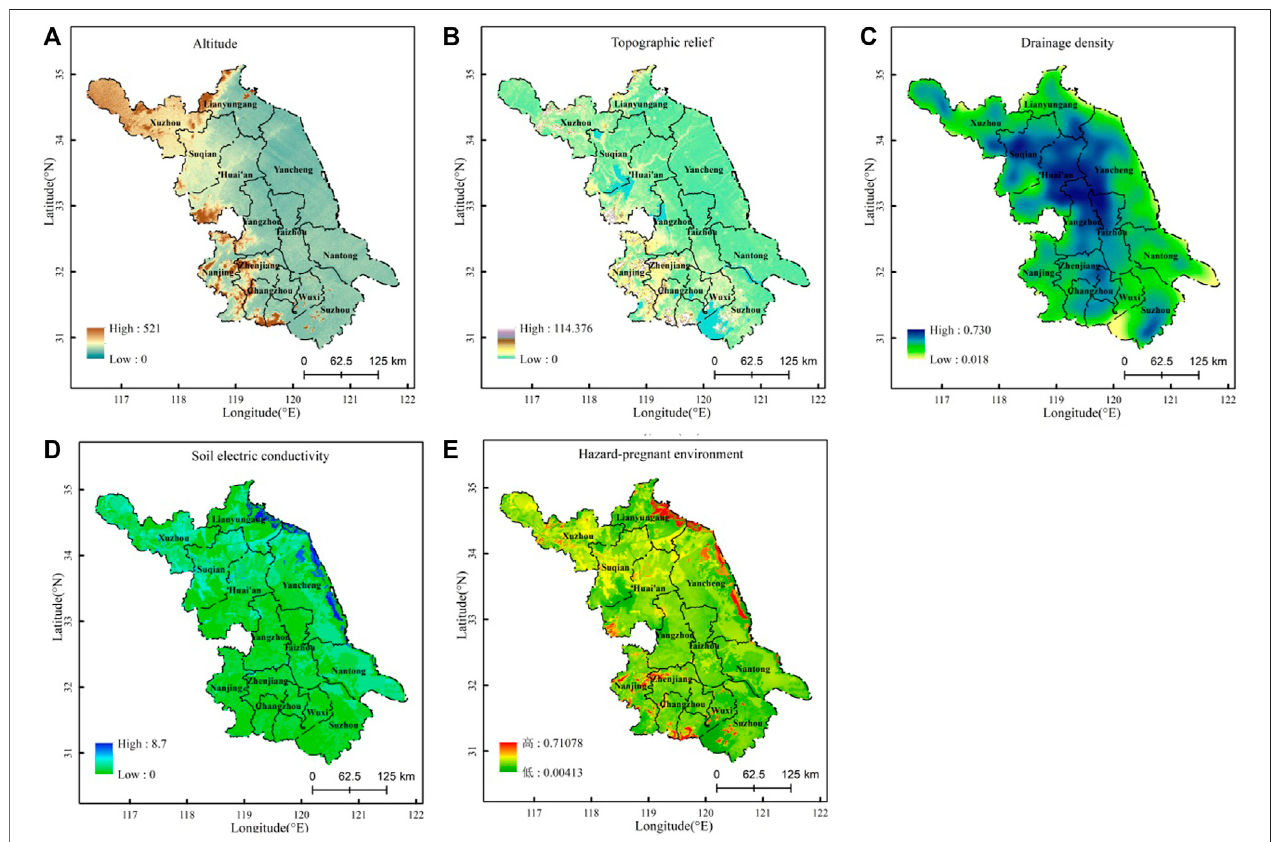
FIGURE4| Distribution ofthesensitivity ofhazard-pregnantenvironment inJiangsu. (A) Altitude,unit: m; (B) Topographicrelief,unit: m; (C) Drainage density, unit: km/km 2 . (D) Soil electric conductivity, unit: ds/m; (E) Hazard-pregnant environment.